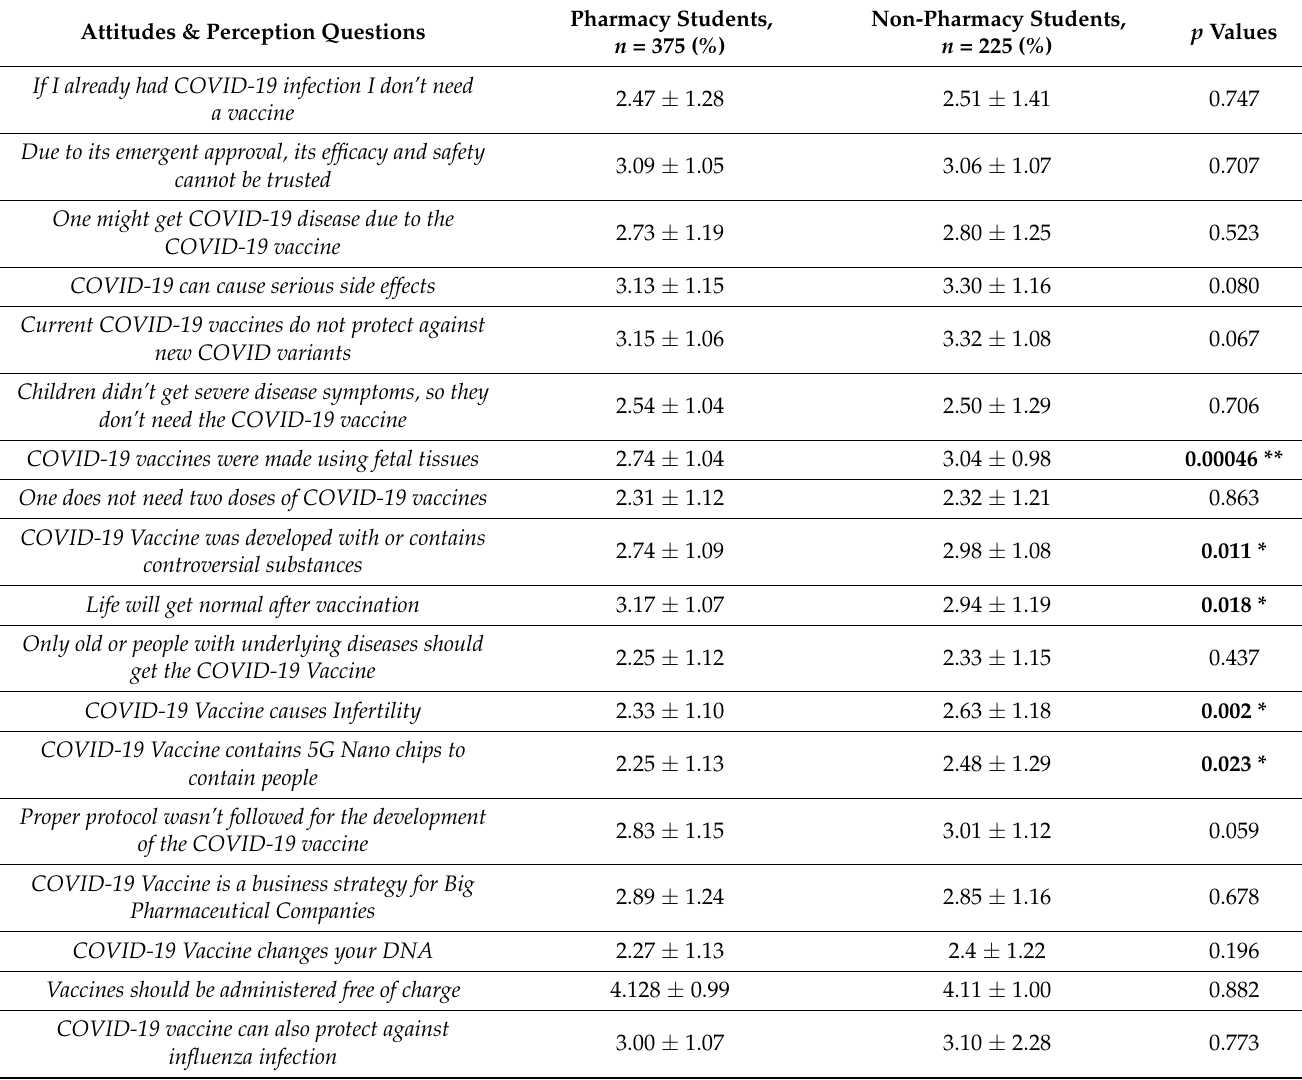
Table 4. Assessment of Attitude and Perception of Students towards COVID-19